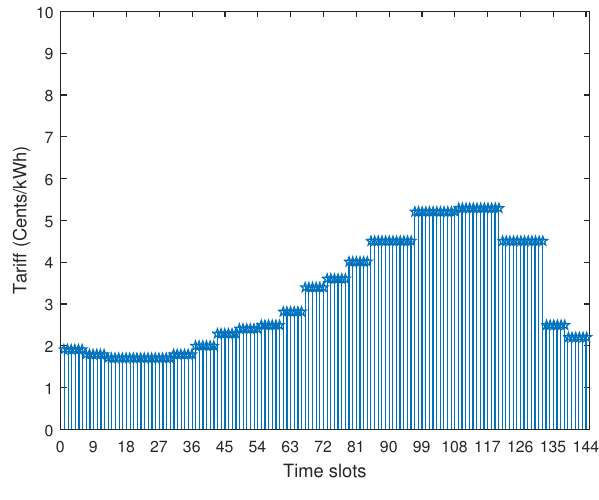
Figure 5. DA-RTP